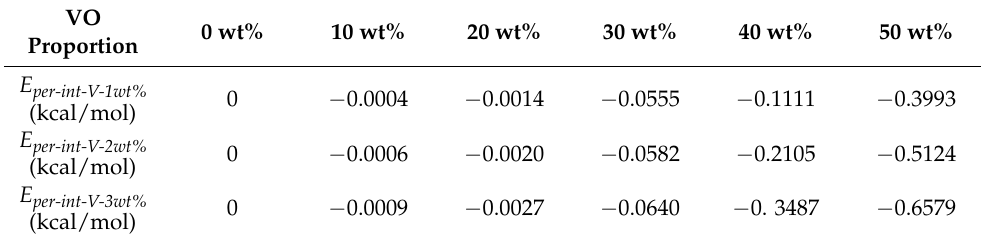
Table 14. The average interaction energy of a single H 2 O molecule and a single VO molecule.